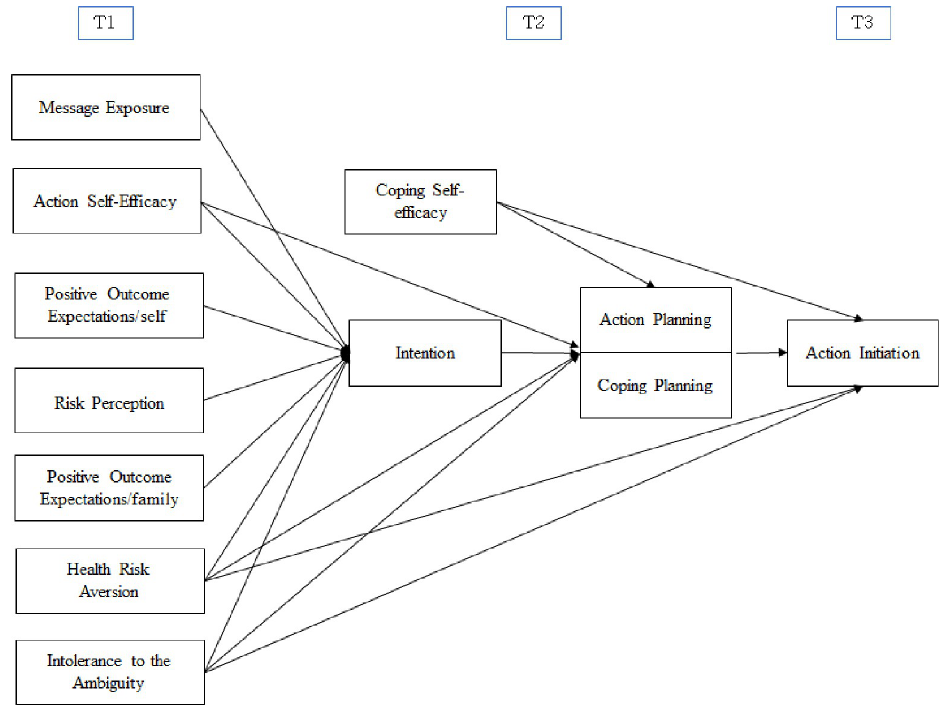
Fig 1. Expected relations between variables. T1, T2, T3 indicate the three different timeframes of the research.